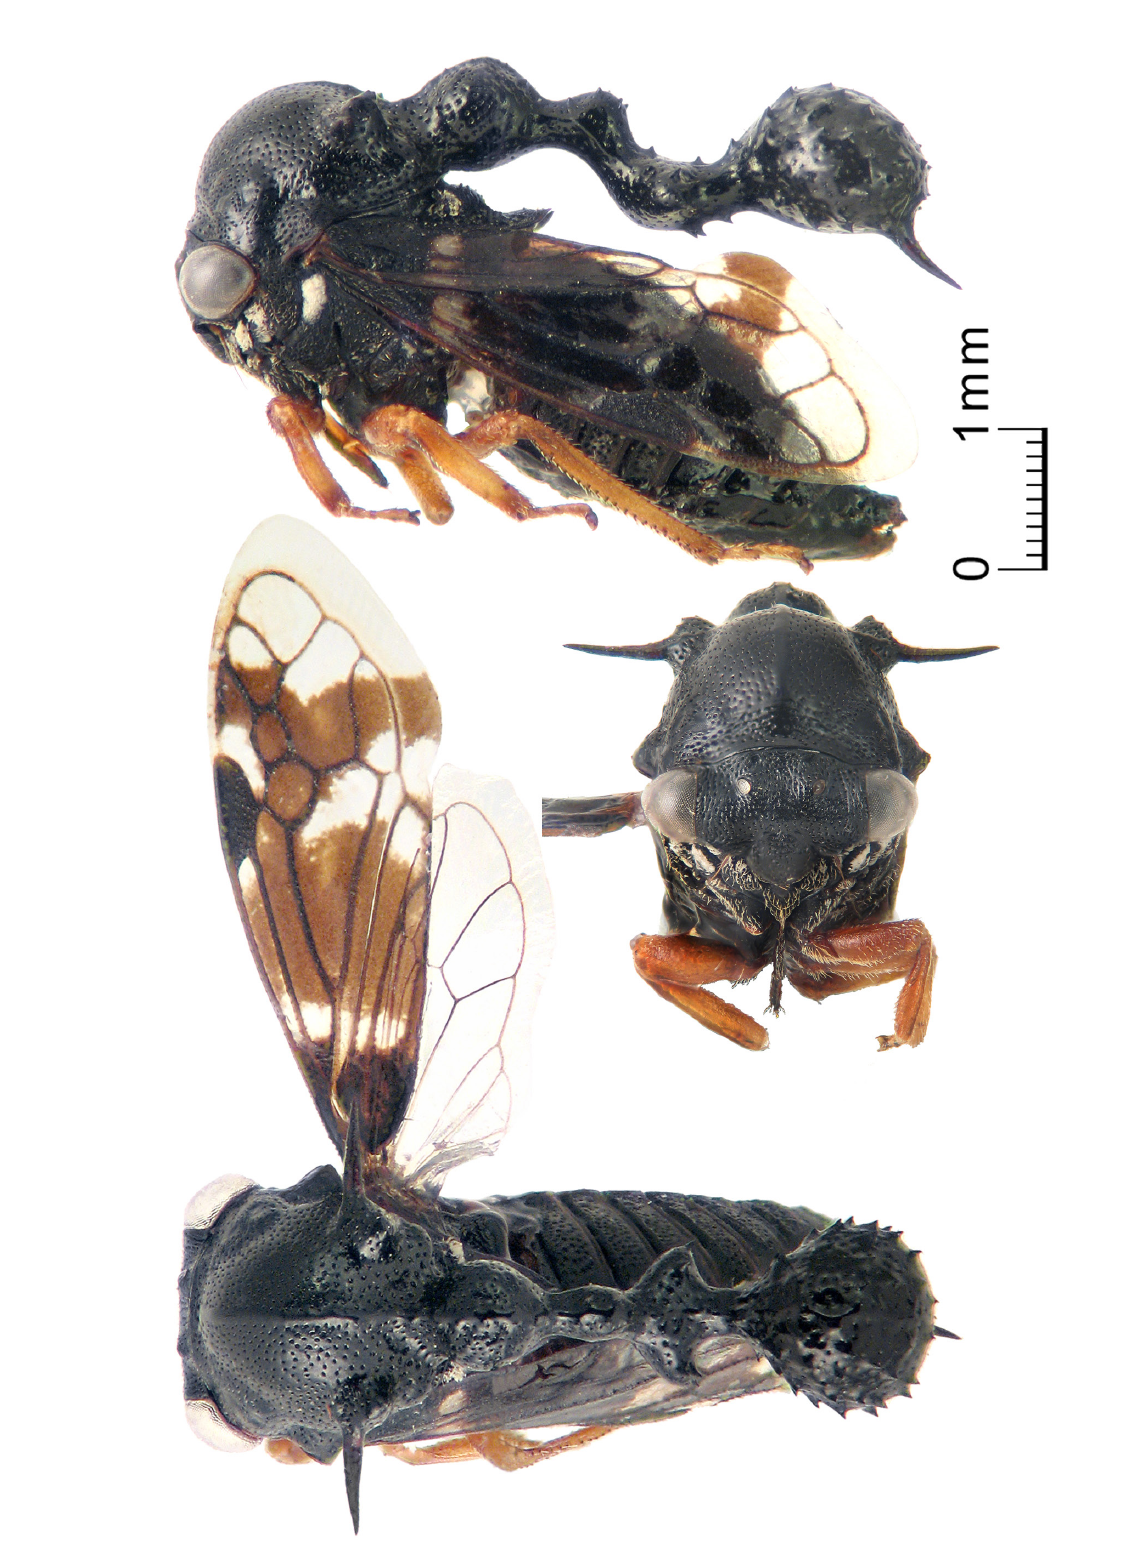
Fig. 1. Hamma nigrum sp. nov., holotype, ♀, Gabon, Ogouè Ivindo, Batuala, 1 Dec. 2012, A. Susini leg.